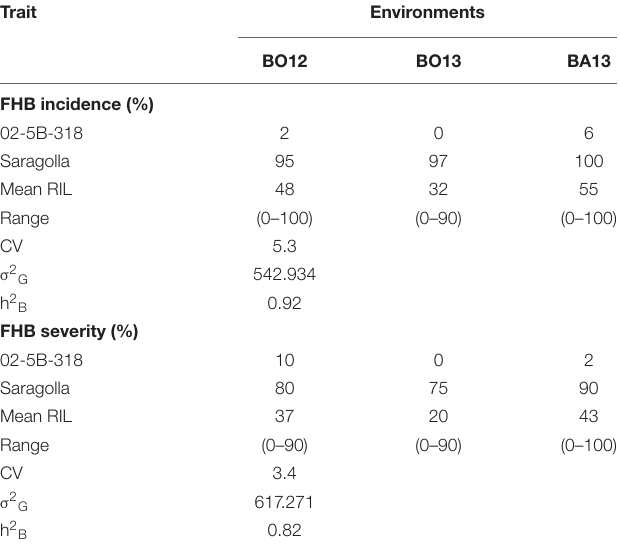
TABLE 1 | Mean, range, genetic variance ( σ 2 G ), and broad-sense heritability (h 2 B ) estimates for FHB incidence (percentage of infected spikes per plant) and severity (percentage of infected spikelets per spike) in the RIL population derived from crossing FHB-resistant 02-5B-318